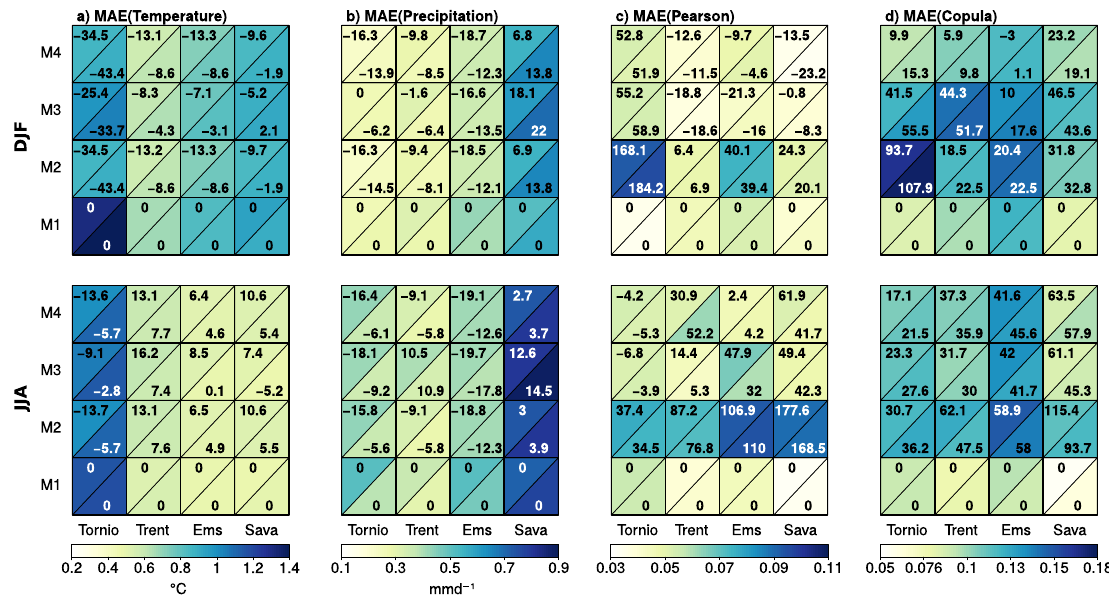
Figure 8. Panels showing the cross-validated MAE (colors) of ( a ) daily mean temperature, ( b ) daily precipitation, ( c ) Pearson correlation coefficient and ( d ) empirical copula density separately for each method (panel rows) at each hydrological sub-domain (panel columns) in years 2061–2090, when two-month time window has been used to estimate simulated changes or model biases. Values for the pseudo-reality approach V0 (V1) are plotted in the upper (lower) triangle of each cell and are shown separately for ( top ) winter and ( bottom ) summer months. In addition, percentage differences to M1 are shown as numeric values for each